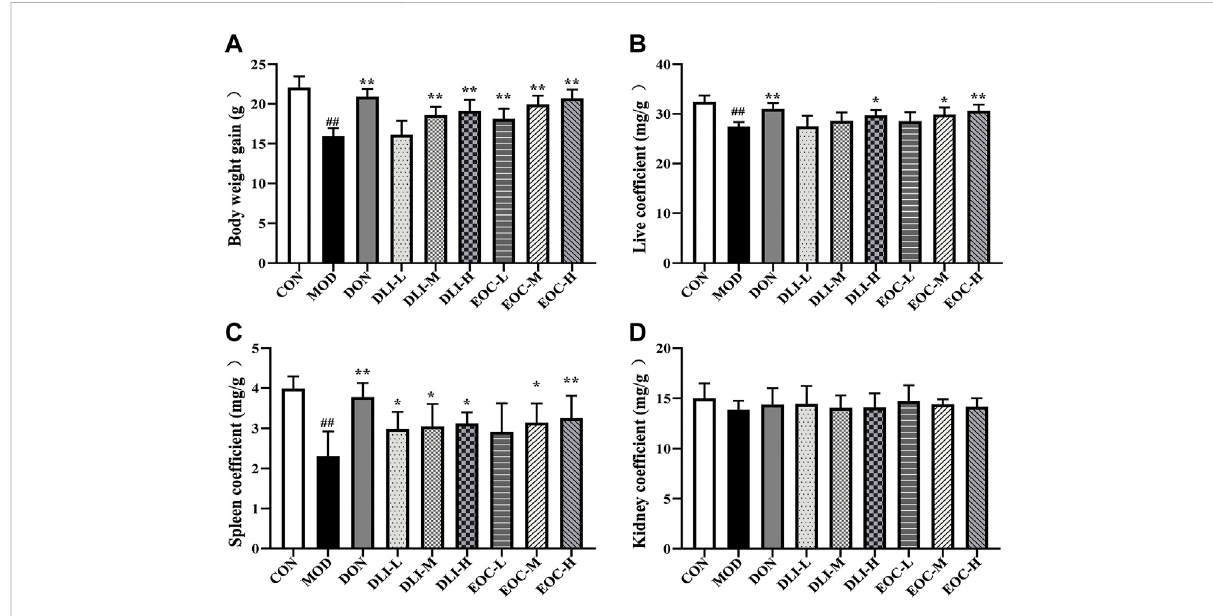
FIGURE 4 Effect ofEOCandDLIonbody weight gainandorgan coef fi cients ( n = 5). (A) Bodyweightgain; (B,C,D) Livercoef fi cient,spleen coef fi cient,and